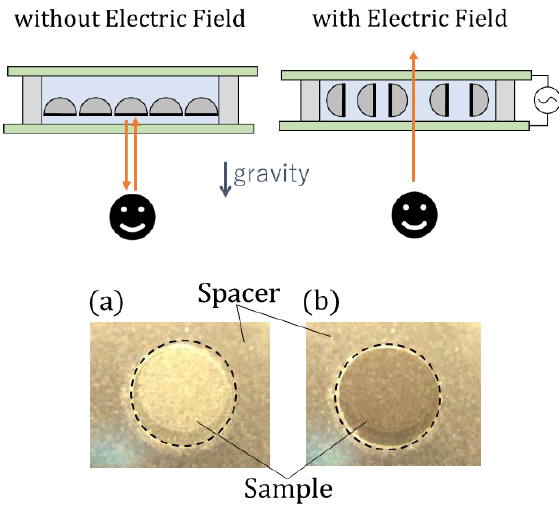
Figure 9. Reflection change of the ITO-sandwiched suspension having the 15.7% cross sectional coverage of the particles observed in a dark room without ( a ) and with ( b ) the electric field when the light was incident from the equatorial side. It is clearly seen that light is reflected in ( a ) and transmitted in ( b ). The sample was irradiated from below by the light emitting diode of a smartphone. The photographic images are captured from the movie (See also Video S2) that was taken with the smartphone held by the observer below.